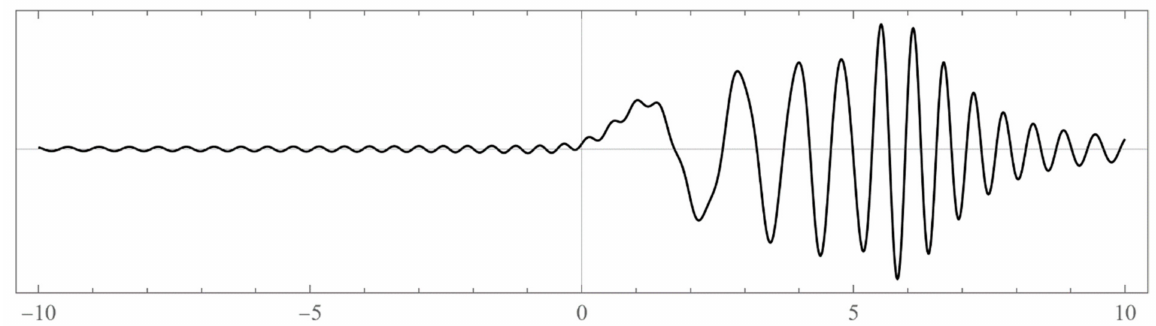
Figure A3. The un-normalized wavefunction (cid:101) ψ ( x , E ) for E = + λ 2 /2. We took N = 100.